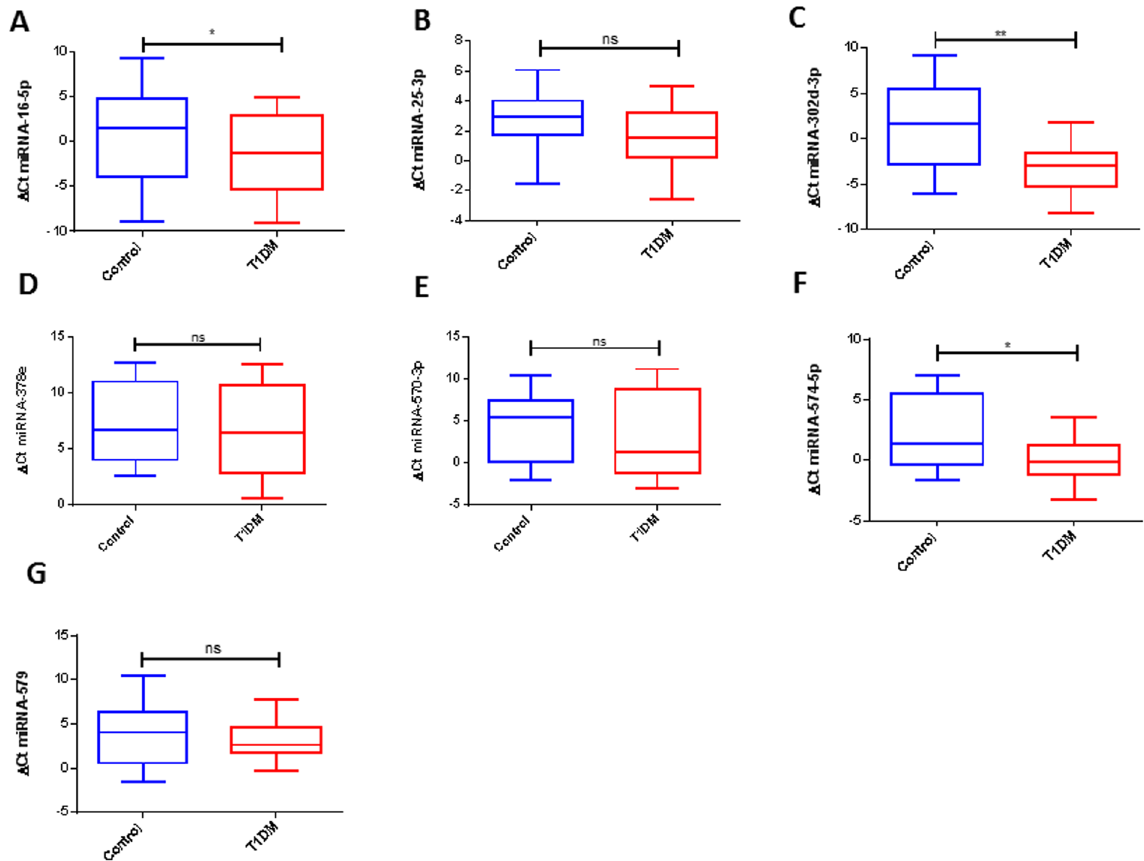
Figure 4. Box-and-whisker plots of the expression levels of the seven selected miRNAs in an independent set of T1DM (n = 24) and control subjects (n = 24). The comparative cycle threshold (Ct) method was used to quantify the levels of exosome miRNAs in T1DM and control subjects. The relative ratio was calculated using the Δ Ct method. The Ct value of miR-631 was used as an internal standard. ( * p-value < 0.05, ** p-value < 0.01, ns = non